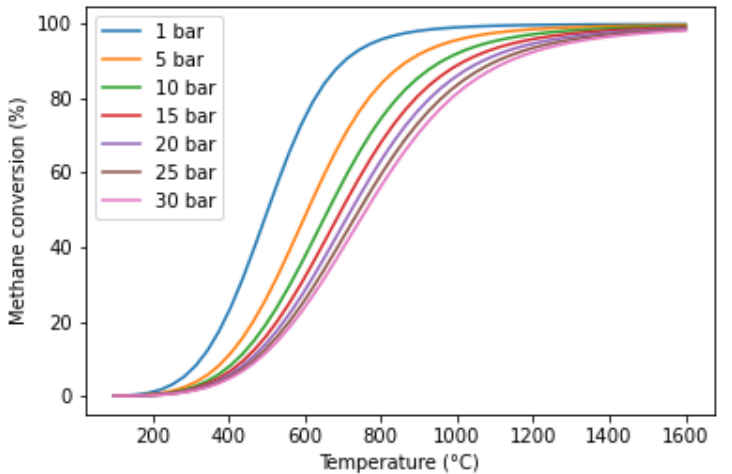
Figure 8. Equilibrium conversion of methane as a function of temperature and pressure (calculations performed with Cantera [152]).